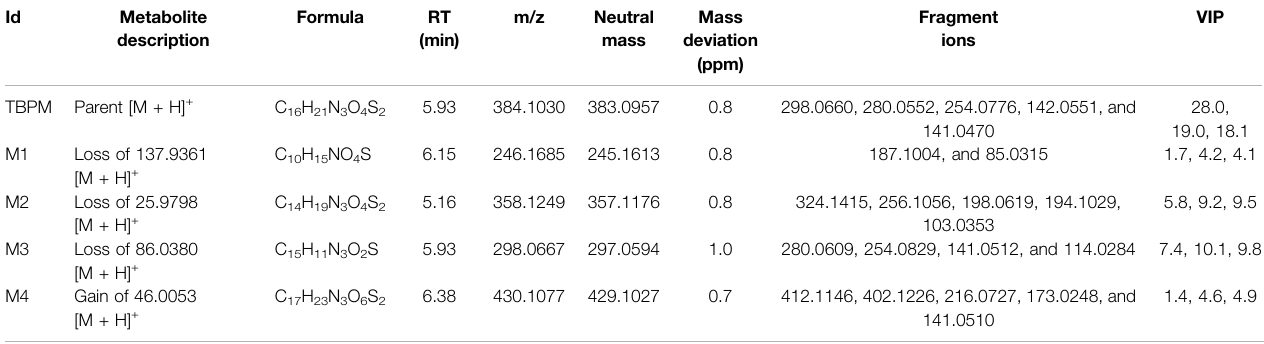
TABLE 4 | Identi fi ed metabolites of TBPM in urine after oral